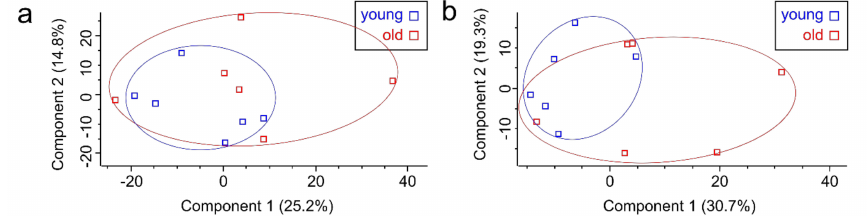
Figure 6. Principal component analysis of cell proteomes ( a ) and secretomes ( b ) of MKTPCs derived from young and older individual